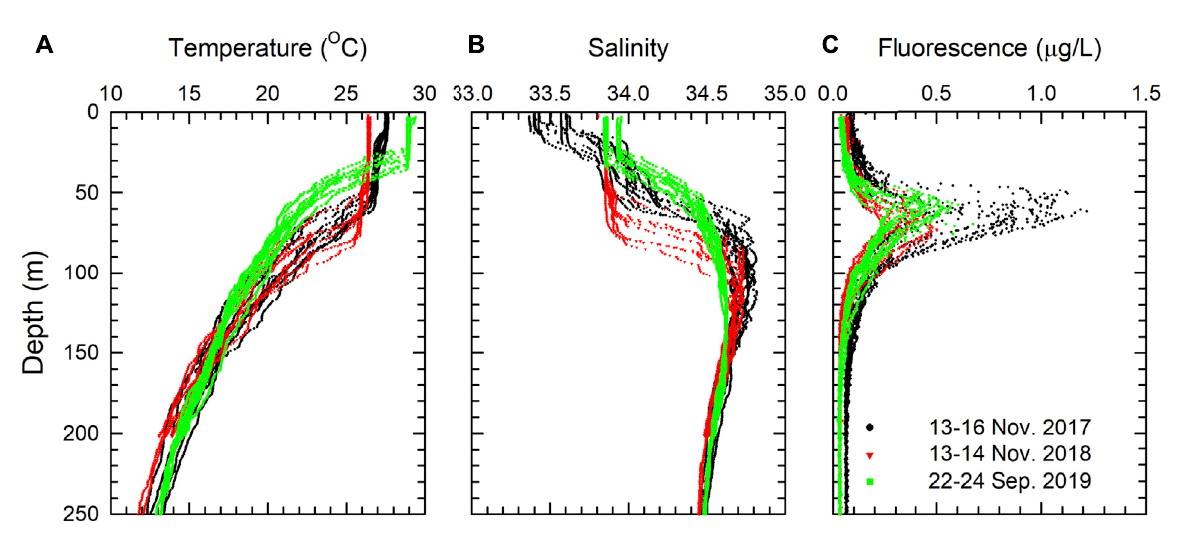
FIGURE 6 Pro fi les of (A) temperature, (B) salinity, and (C) fl uorescence obtained from onboard RV ORI CTD. The casts were conducted during the deployment and recovery of sediment trap moorings near the SEATS site from 13 – 16 November 2017 (in black), 13 – 14 November 2018 (in red), and 22 – 24 September 2019 (in green).